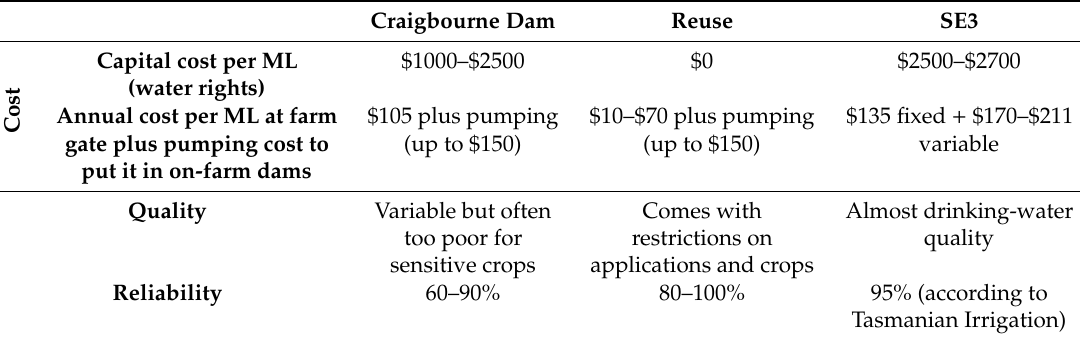
Table 3. Water sources and range of values for the most relevant characteristics.